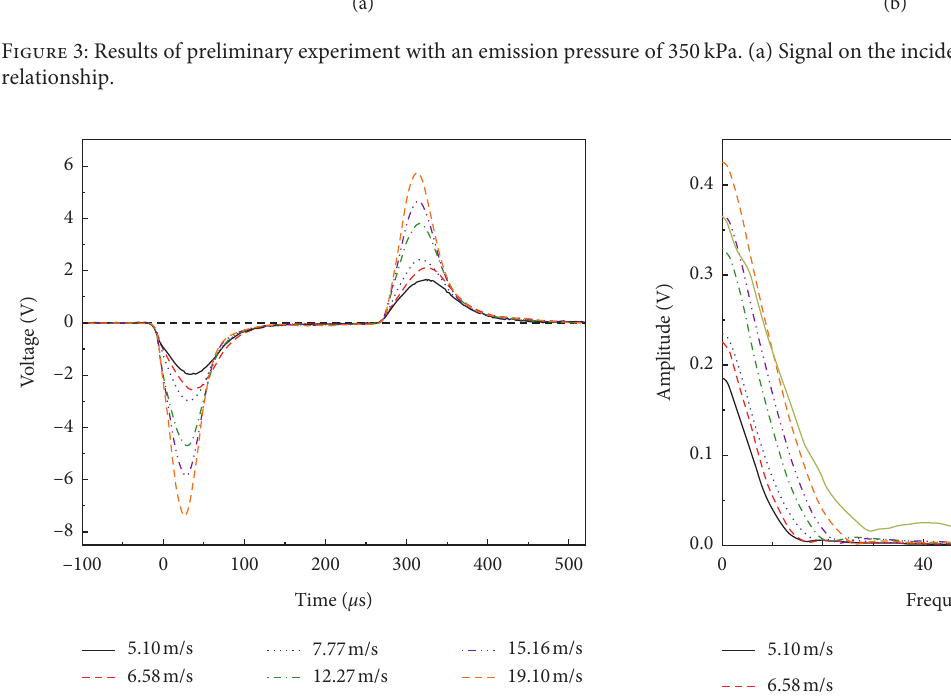
Figure 4: Signals on the incident bar at different impact velocities.